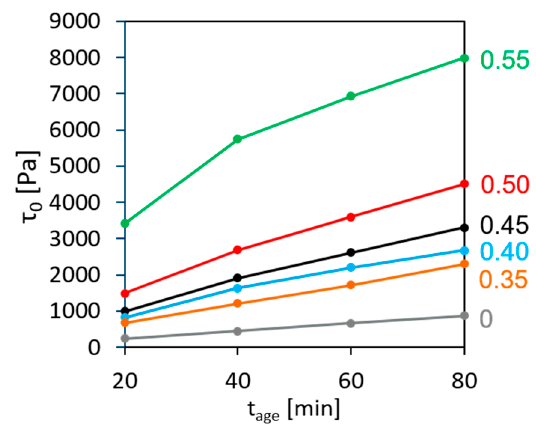
Figure 2. Development of static yield stress over age of concrete with various volume fractions of aggregates.